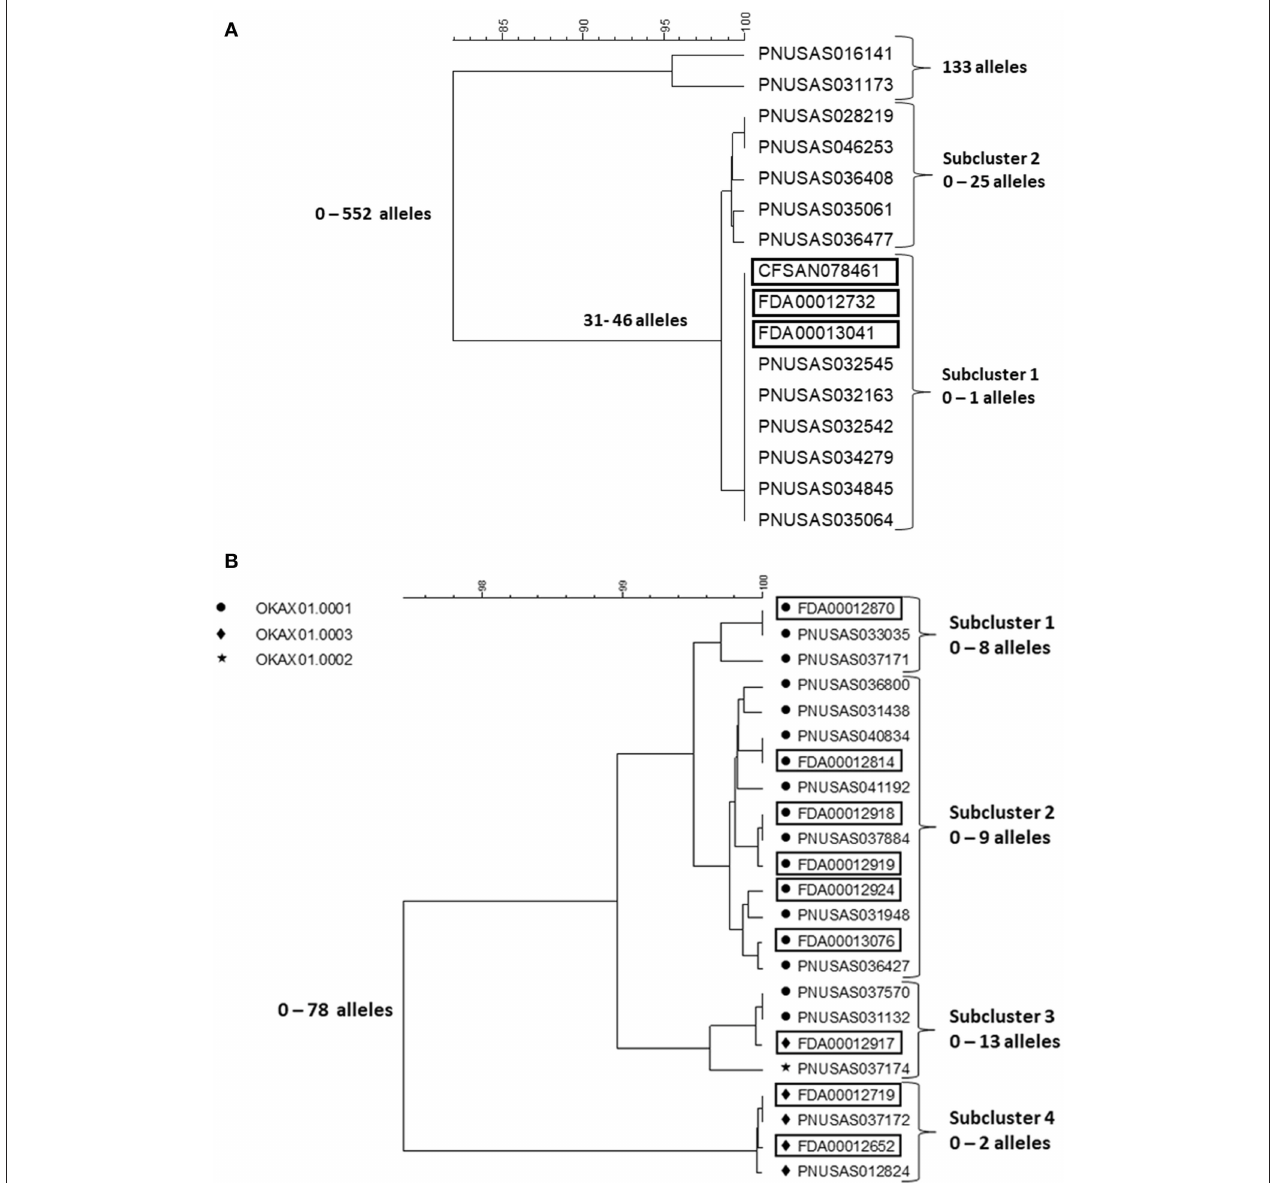
FIGURE 3 | cgMLST UPGMA trees of representative samples of sequences of Salmonella ser. I 4,[5],12:b:- (A) and Okatie (B) . Isolates of ser. I 4,[5],12:b:- all displayed the same PFGE pattern. Isolates of ser. Okatie displayed three PFGE as indicated on the figure. Product isolate identifiers are indicated with rectangles around them. The range of allele differences are indicated at the branches of the tree and subclusters to the right of the